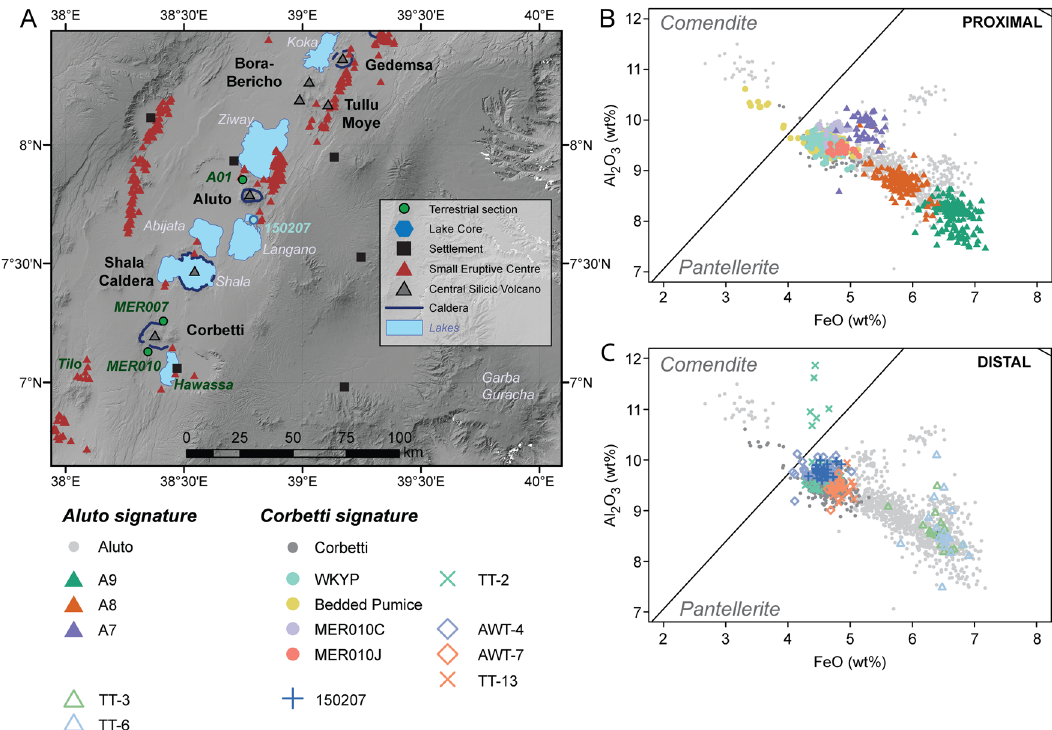
Fig. 5 Geochemistry of Central Main Ethiopian Rift Volcanoes. A Map showing type sections of pyroclastic stratigraphy (green dots) and lake sediment cores (blue pentagons) near Aluto and Corbetti volcanoes in the Main Ethiopian Rift. All show multiple volcanic ash layers that can be attributed to Aluto or Corbetti and demonstrate the potential of developing a regional-scale multi-volcano tephrostratigraphic framework. The light green dot to the south of Aluto shows a locality of a pyroclastic deposit (150207) that has a Corbetti signature. Modi fi ed after 10 . B Chemical signatures of Aluto and Corbetti proximal deposits. C Chemical signatures of Aluto and Corbetti distal deposits The Corbetti signature plots as a cluster near 9 – 10 wt% Al 2 O 3 and 4 – 5 wt% FeO, whereas the Aluto chemical compositions partially overlap this cluster, but span a much wider range and are thus easier to